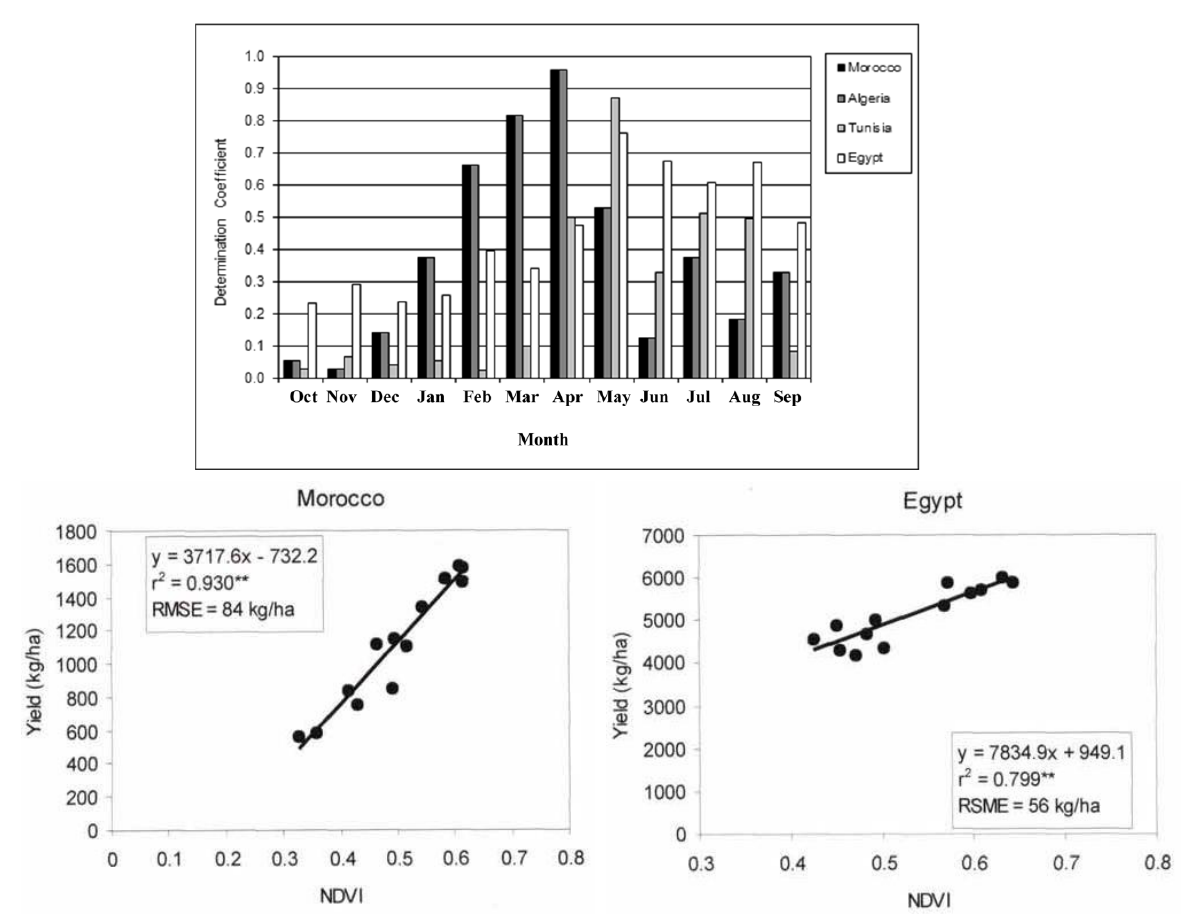
Figure 4. NDVI/yield linear regressions for cereals in North Africa (from Maselli and Rembold [46]; modified). ( Top ) Evolution of the coefficient of determination (R2) between radiometric variable and yield over time. ( Bottom ) Scatter plots between NDVI and cereal yield. Each dot corresponds to the annual yield for agricultural areas at national level and to the monthly NDVI best correlated to